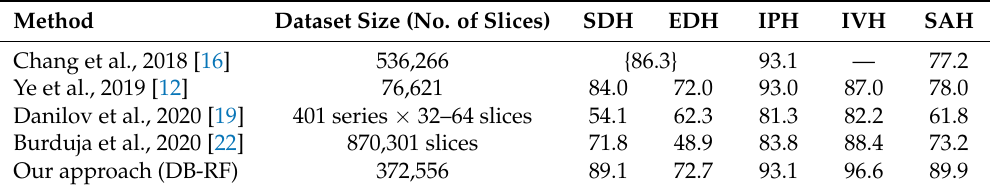
Table 4. Comparison of classification F1 scores obtained using state-of-the-art methods [12,16,19,22] and our double-branch random forest (DB-RF) model. All values in